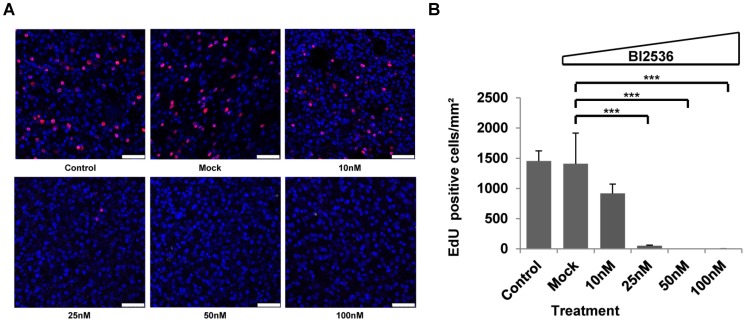
Long-term BI 2536 effects on E. multilocularis metacestode vesicles.Metacestode vesicles were treated for 21 days with different concentrations (10, 25, 50 and 100 nM) of BI 2536, followed by three days of recovery without inhibitor. On day three of recovery, EdU labeling (5 h, 50 µM EdU) was carried out and labeled cells were microscopically counted. (A) Microscopic images of the GL of BI 2536 treated (10, 25, 50, 100 nM) and non-treated E. multilocularis metacestode vesicles, stained with EdU. Bar represents 25 µm. Blue, nuclear staining, DAPI; red, EdU staining. (B) EdU-positive cell counts per mm2 of GL. ‘Control’ indicates vesicles cultivated in A4 medium alone. ‘Mock’ indicates the DMSO control. ***(p<0.001) (Student's t-test). Please note that the specific examples shown in (A) display slightly different total cell numbers but that the overall cell numbers in metacestode vesicles were not altered by drug treatment, as already outlined in [14] for HU treatment.